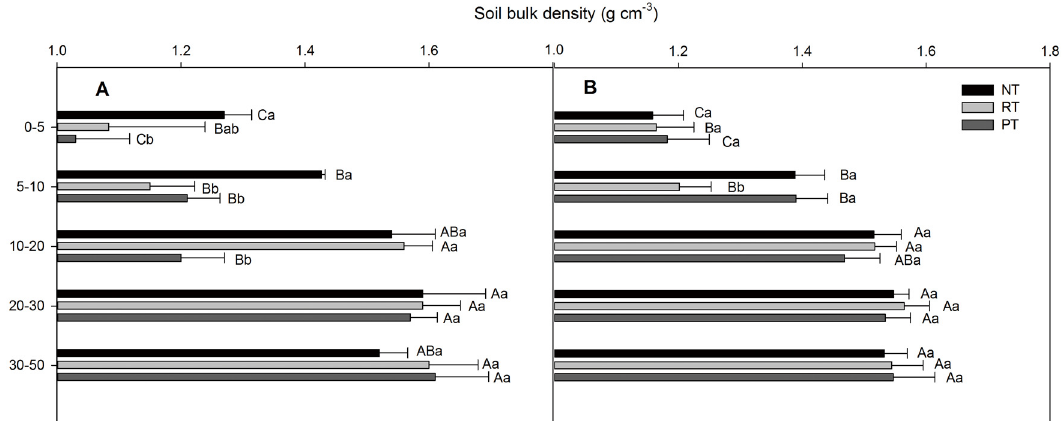
Fig 1. Depth distribution of the soil bulk density ( ρ b ) under different tillage practices. No till (NT), rotary tillage (RT) and plow tillage (PT); (A) after the maize harvest and (B) after the wheat harvest. The data are presented as the means ± SD (n = 3). The various capital letters indicate significant differences among the soil depths, and the lowercase letters indicate significant differences among the treatments ( P < 0.05).